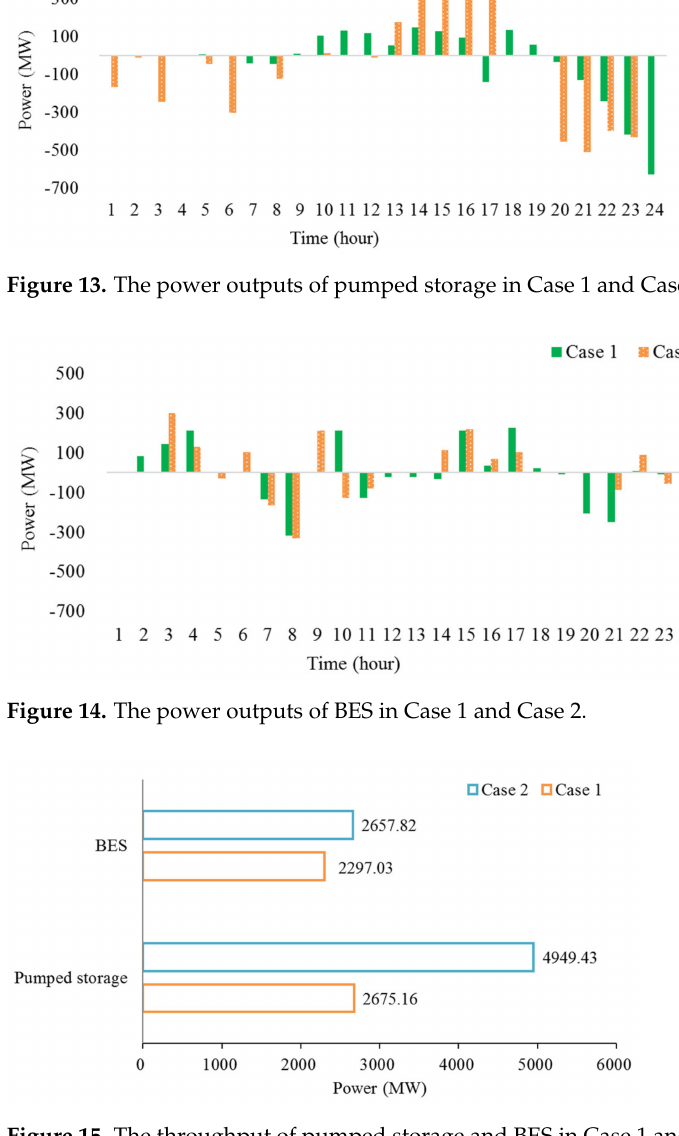
Figure 15. The throughput of pumped storage and BES in Case 1 and Case